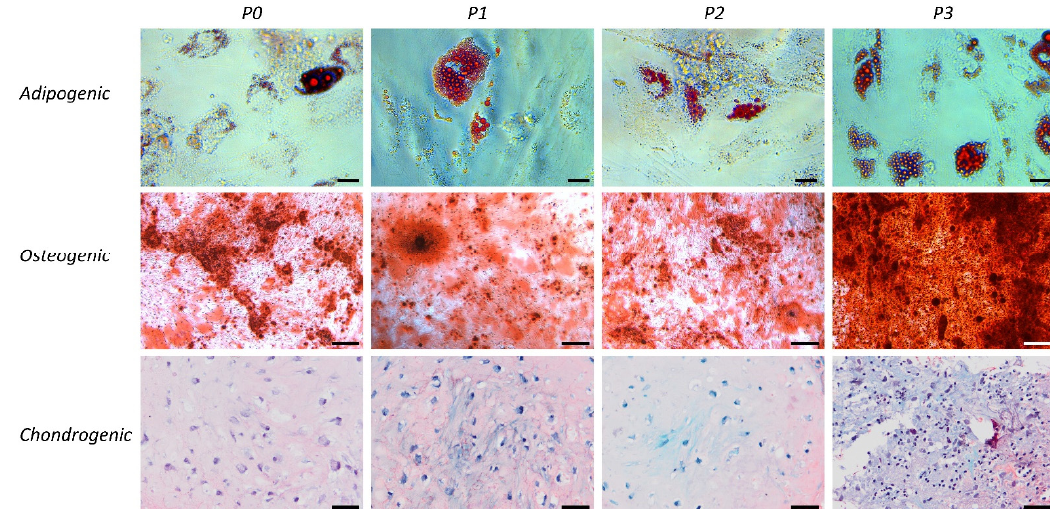
Figure 3. Representative bright-field microscope images of tissue-like stromal vascular fraction (tSVF) at P0, P1, P2 and P3 differentiated into the adipogenic (upper, 40× magnification), osteogenic (mid, 10× magnification) and chondrogenic (lower, 10× magnification) lineages as shown by stainings with oil red O, alizarin red and safranin-O, respectively. The scale bar of the adipogenic images is 10 micrometer and 50 micrometer, respectively, for the osteogenic and chondrogenic images. P = passage.